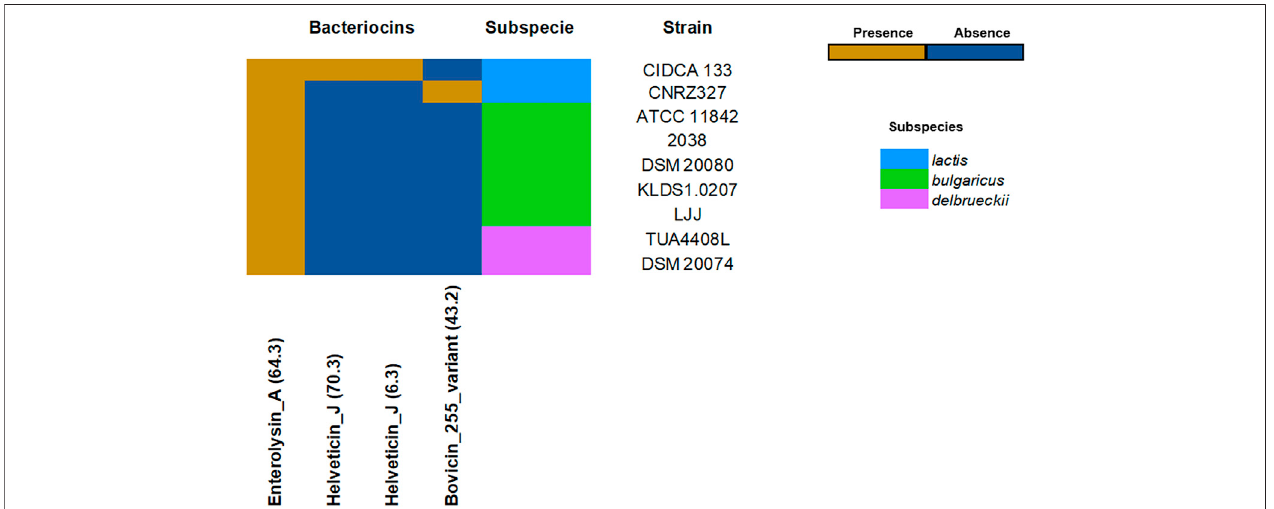
FIGURE 3 | Bacteriocins pro fi le across probiotics L. delbrueckii strains. The heatmap indicates the presence (dark yellow) or absence (dark blue) of bacteriocins- encoding